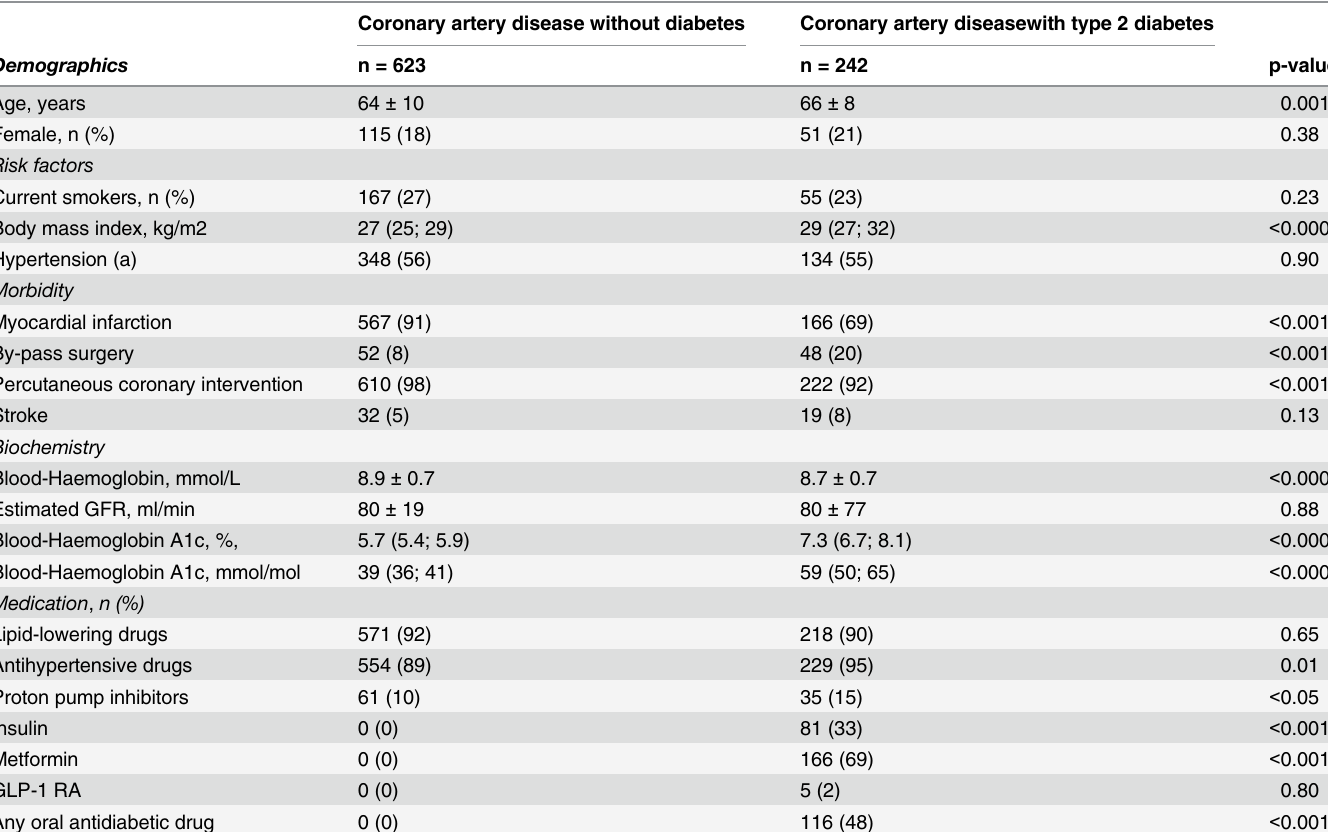
Table 1. Clinical characteristics of the study population of coronary artery disease patients with and without known type 2 diabetes, n = 865. Coronary artery disease without